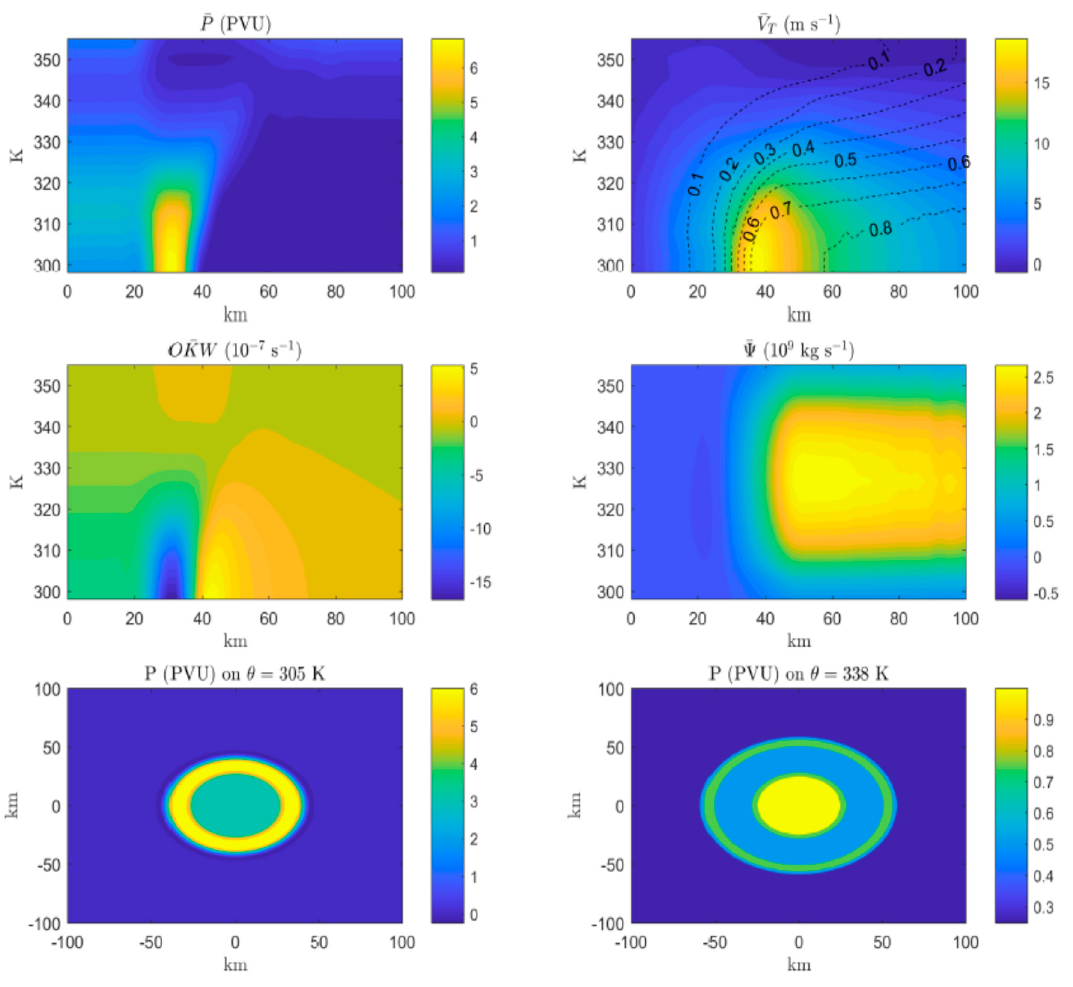
Figure 3. Same as Figure 2, except for (cid:1872) = 4 h